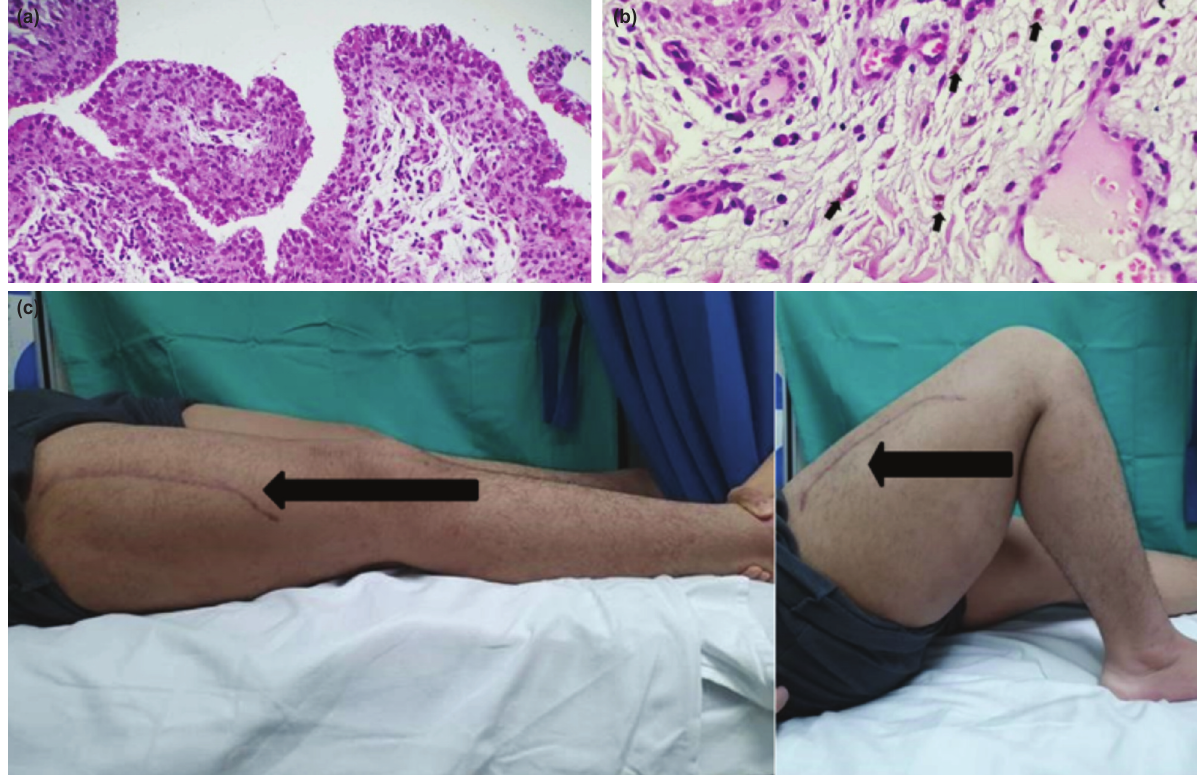
(a) H&E 20x Histopathology examination shows papillary structures lined with the hyperplastic synovial lining, (b) H&E 40x Fig. 3: Hemosiderin-laden macrophages (black arrow), (c) Photographs of right knee ROM at two years of follow-up. (The black arrow indicates a surgical scar for femur fracture treatment six months prior to current